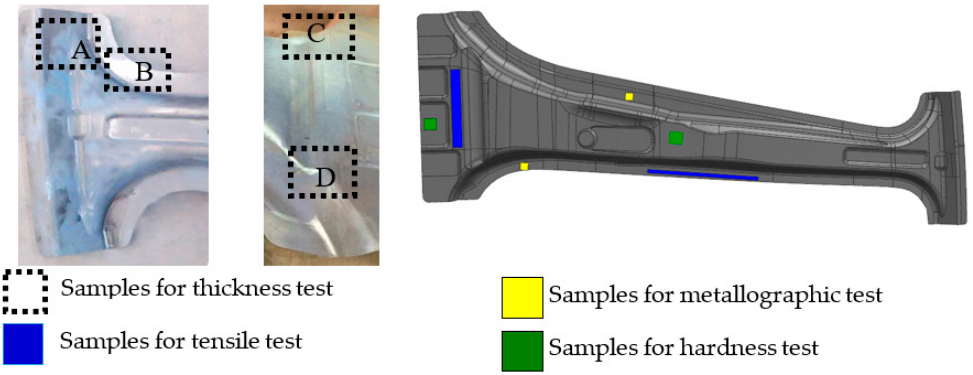
Figure 15. Test sampling location.